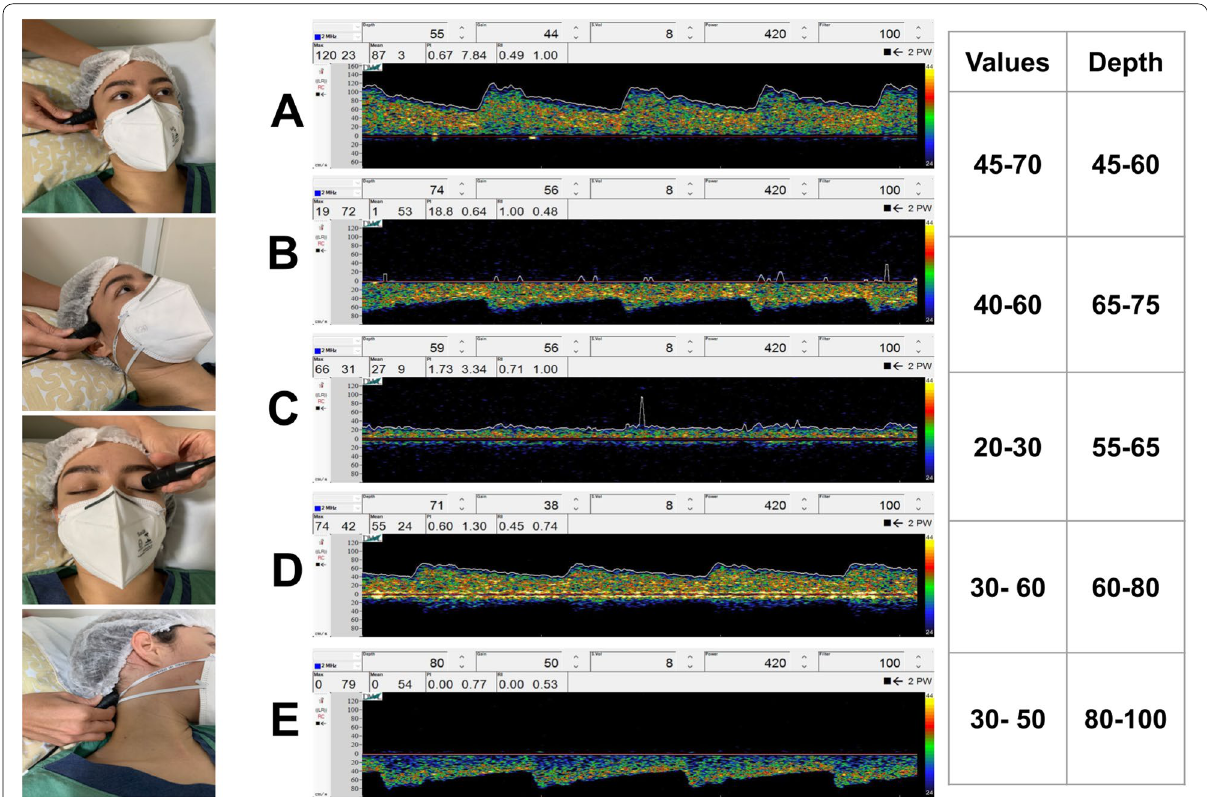
Fig. 2 The figure represents the transtemporal, transorbital, and suboccipital bone window and the normal curve of blood flow velocity with its pattern, depth, value, pulsatility, and resistance index. A Transtemporal window and middle cerebral artery in 55mm of depth. B Anterior cerebral artery in 74mm of depth. C Posterior cerebral artery in 59mm of depth. D Transorbital window and siphon artery in 70mm of depth. E Suboccipital window and Basilar artery in 80–110mm of